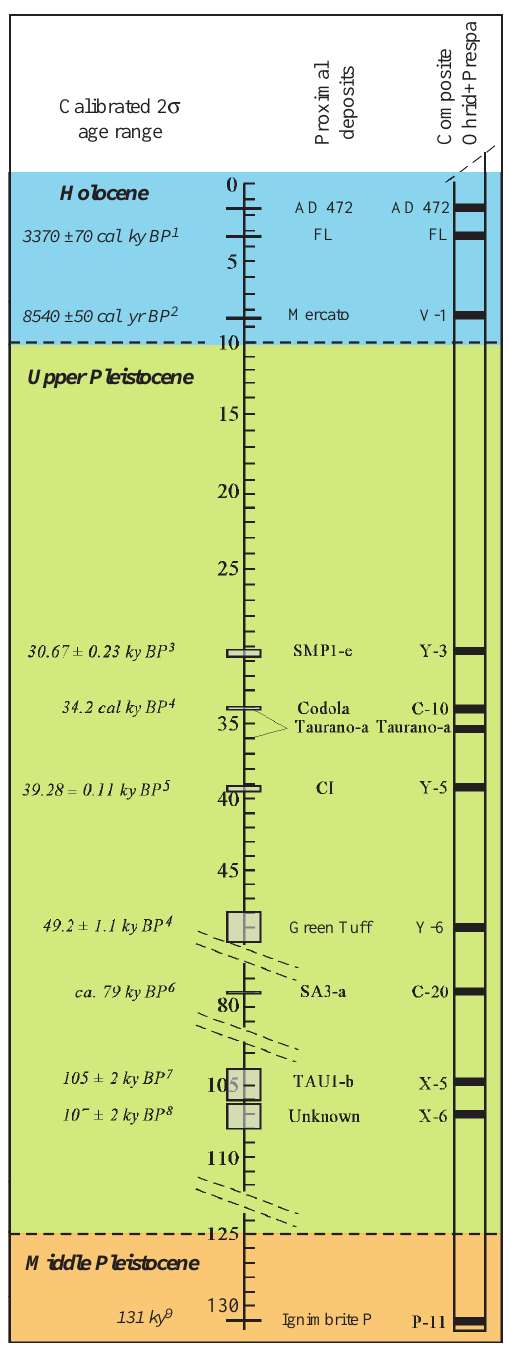
Fig. 7. Updated tephrochronology for the last 131kyr of lakes Ohrid and Prespa. Grey boxes indicate the age uncertainties for cal- ibrated 14 C data and for 39 Ar/ 40 Ar ages. 1 Coltelli et al. (2000); 2 Zanchetta et al. (2010); 3 Di Vito et al. (2008); 4 Vogel et al. (2010); 5 De Vivo et al. (2001); 6 Paterne et al. (1988); 7 Kraml (1997); 8 Allen et al. (1999); 9 Paterne et al. (2008). The three colours indi- cate the Middle Pleistocene, Upper Pleistocene and